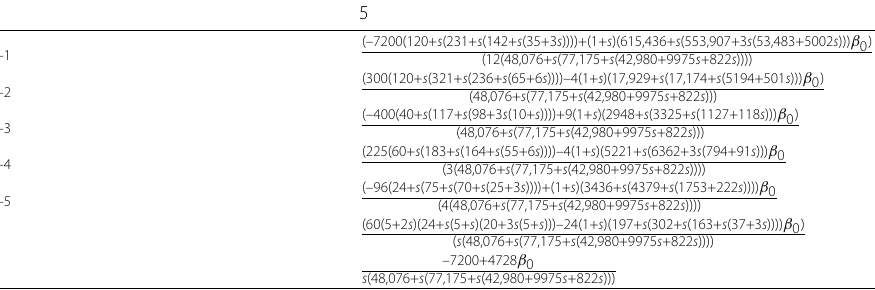
Table 3 The coefficients of method (2.2) for order 6